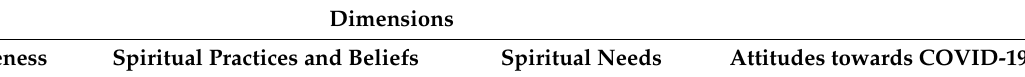
Table 4. Matrix of rotated components of spiritual intelligence and attitudes towards COVID-19; mean, median, standard deviation (SD), and Cronbach’s